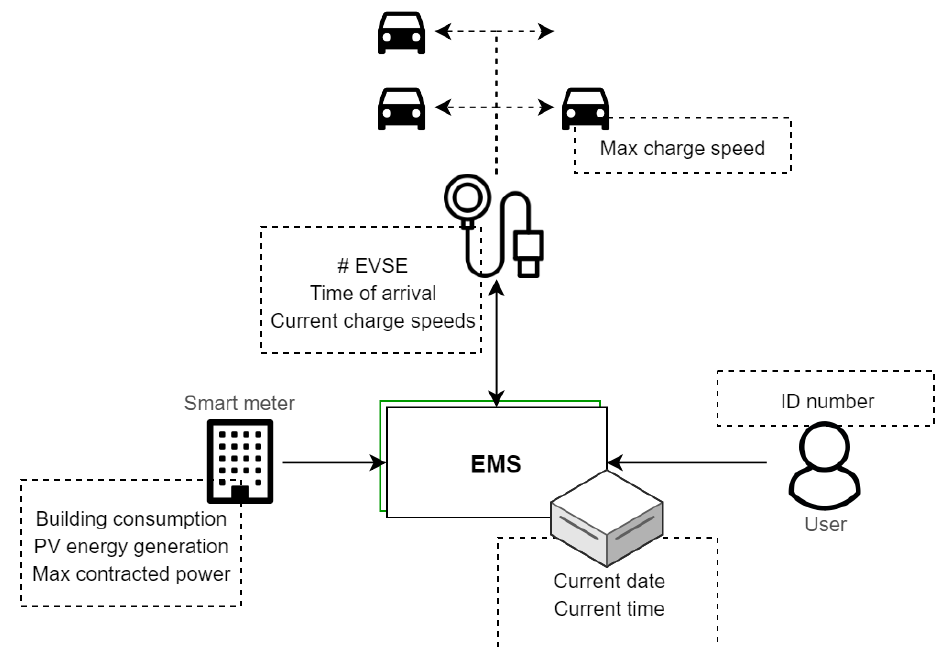
Figure 12. Data and their sources used in the short-term system design.